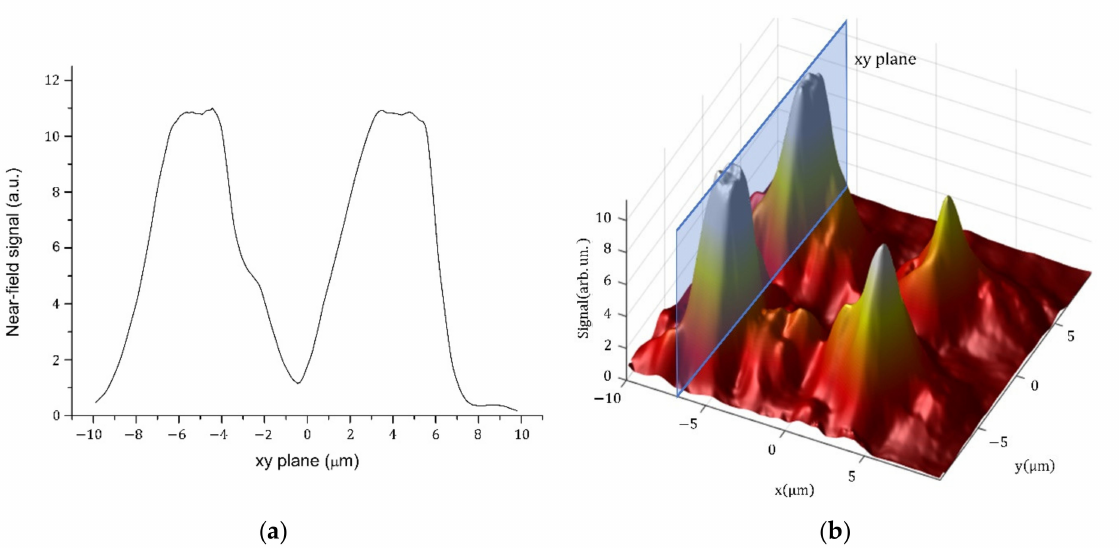
Figure 8. The cross-section of the optical field intensity at the output part: ( a ) along the two planes, as shown in ( b ) 3D interpretation of the intensity